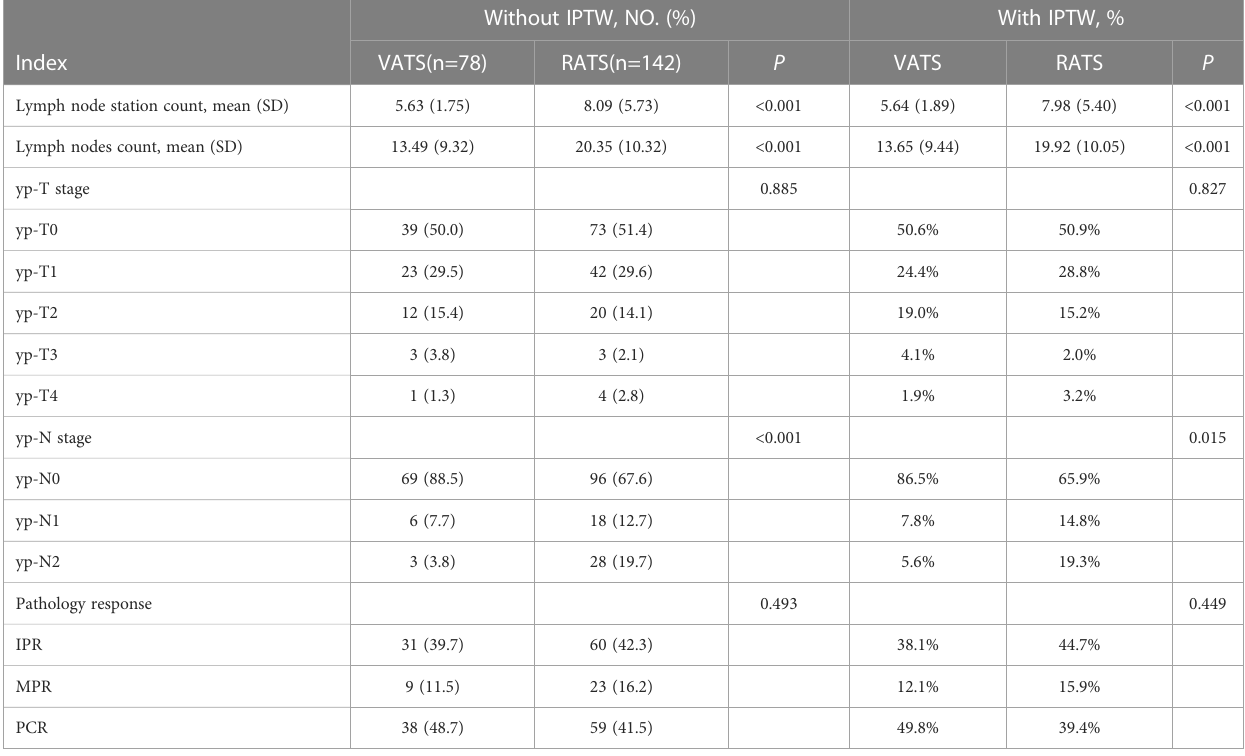
TABLE 3 Unadjusted and IPTW adjusted pathological details and oncologic